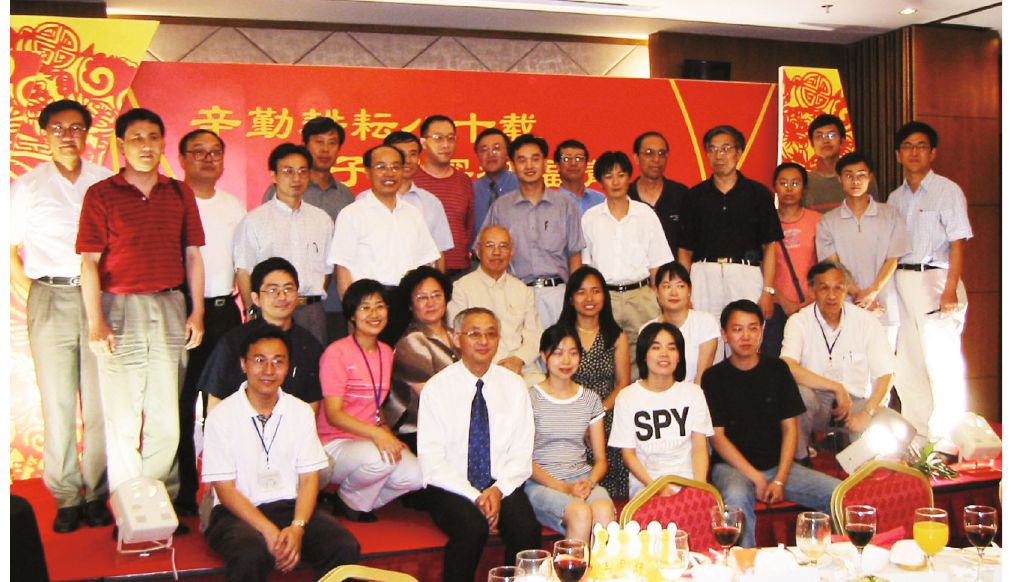
Figure 4. With his former students who attended his 80th birthday celebration in Beijing, August 23rd, 2003 (Second row,